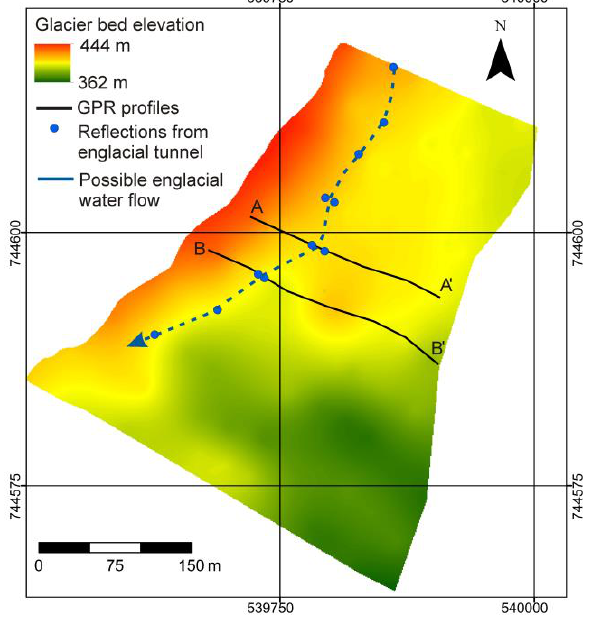
Figure 6. Subglacial topography of studied area of the Russell glacier. Black lines are GPR profiles shown in Fig. 4. Blue dots mark the reflection form possible englacial tunnel